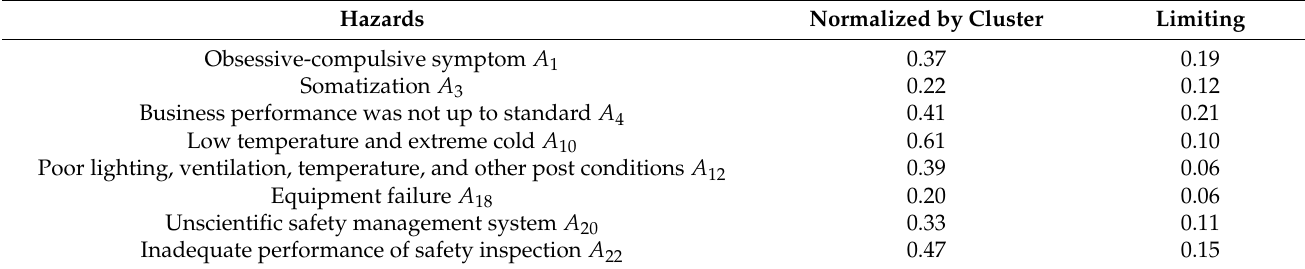
Figure 9. Network structure diagram of the hazard factors in the grid G H . Table 9. The weight value of the hazard factors in the grid G H